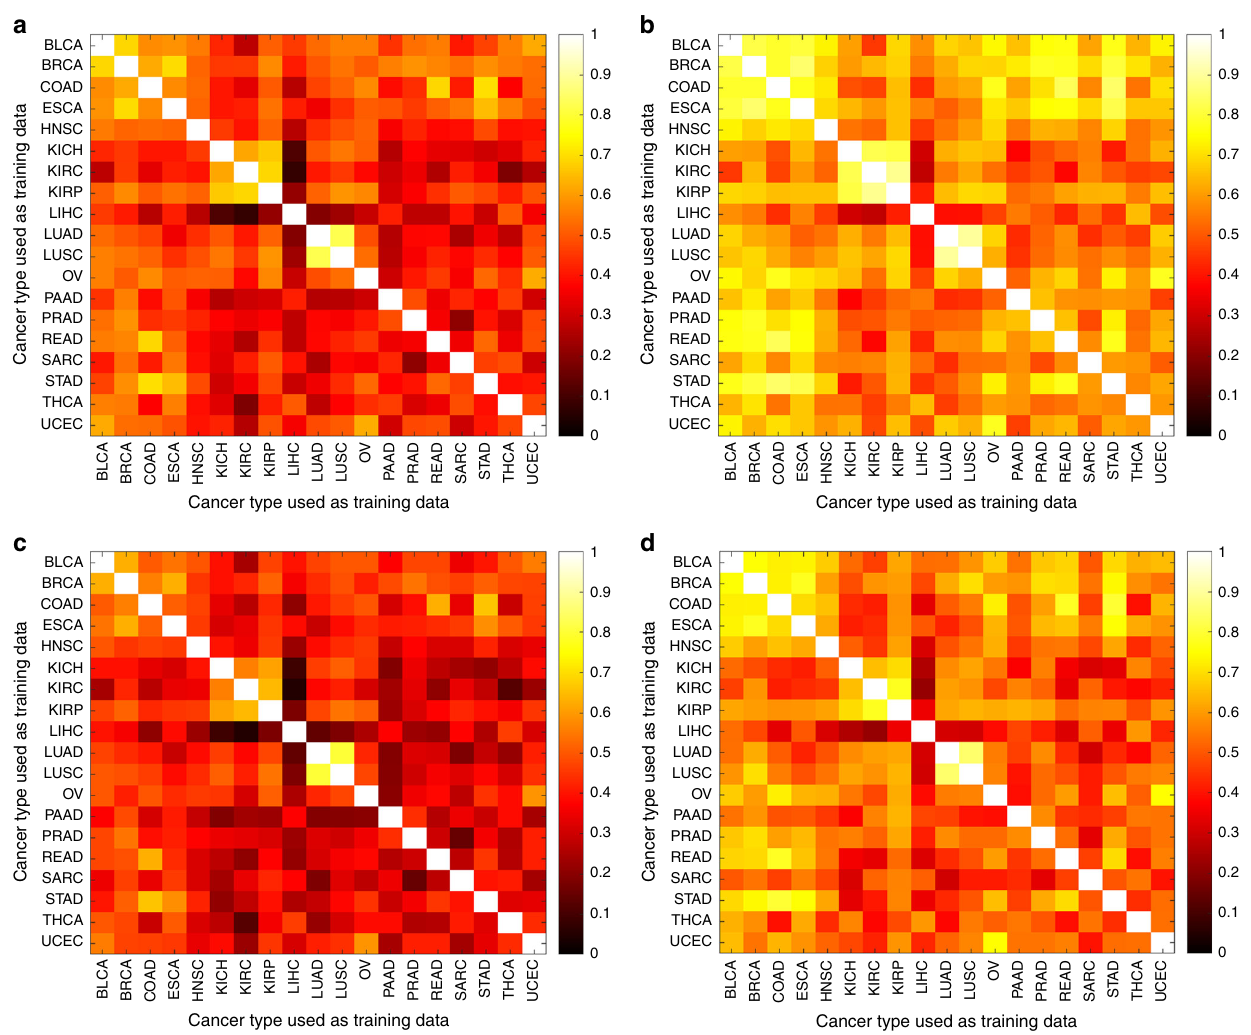
Fig. 5 Tile-level cross-classi fi cations as a function of test set. Correlations of predicted tumor/normal status (i.e., logit of tumor probability) between pairs of classi fi ers, speci fi ed on the x and y axis. Correlations are fi rst calculated using the tile values for all slides of a given test tissue. a Average correlation across tissues, using both tumor and normal slides in the tissue test sets. b Correlation for the tissue set with the maximal correlation, using both tumor and normal slides in the tissue test sets. c Average correlation across tissues, using only tumor slides in the tissue test sets. d Correlation for the tissue set with the maximal correlation, using only tumor slides in the tissue test